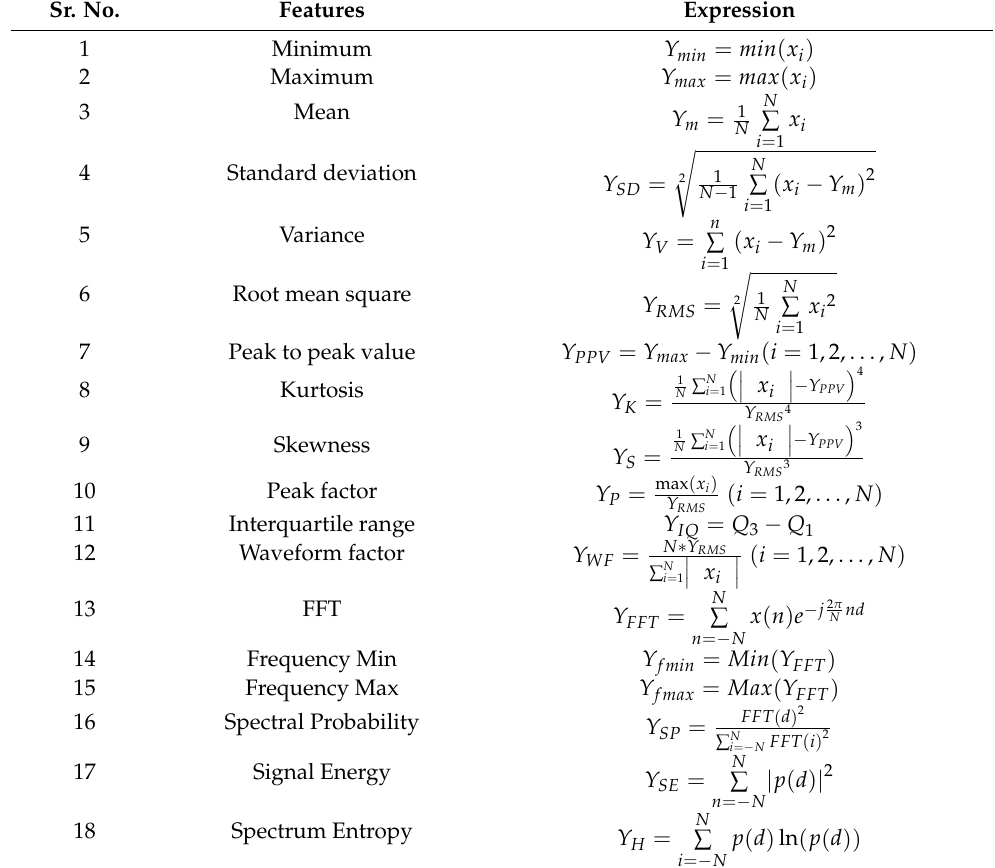
Table 4. Statistical features expressions for classification.